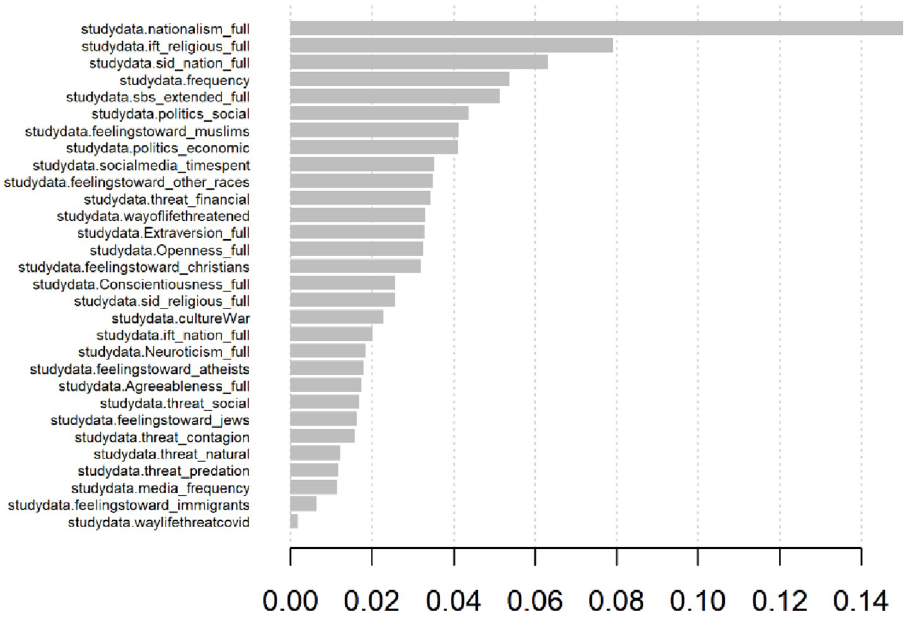
Fig 14. Importance of key factors in predicting if someone will hold anti-immigrant